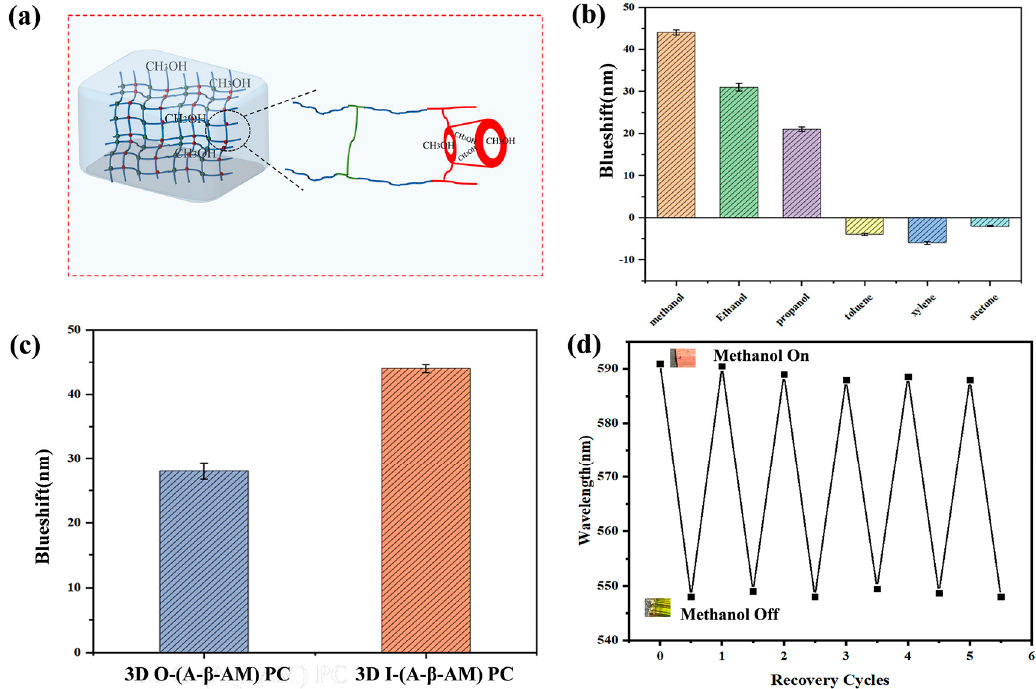
Figure 7. ( a ) Schematic diagram of methanol entering the interior of the sensor; ( b ) the responses of vapors by 3D O-(A- β -CD)-AM PC; ( c ) comparison of 3D O-(A- β -CD)-AM PC and 3D I-(A- β -CD)- AM PC to methanol vapor; ( d ) cyclability of 3D I-(A- β -CD)-AM